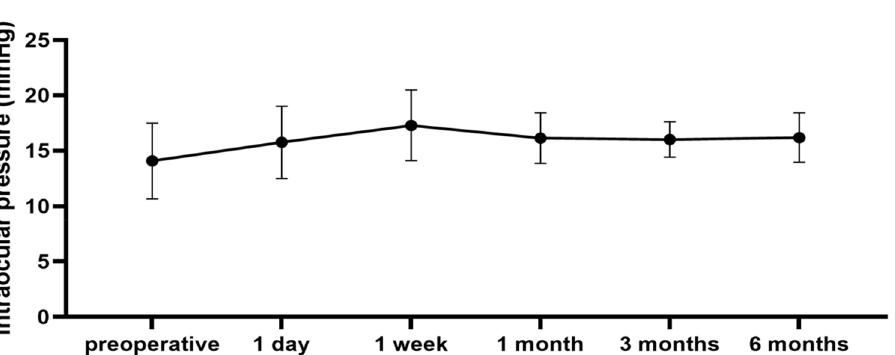
Figure 2. Intraocular pressure outcome of patients undergone pars plana vitrectomy with air tamponade for rhegmatogenous retinal